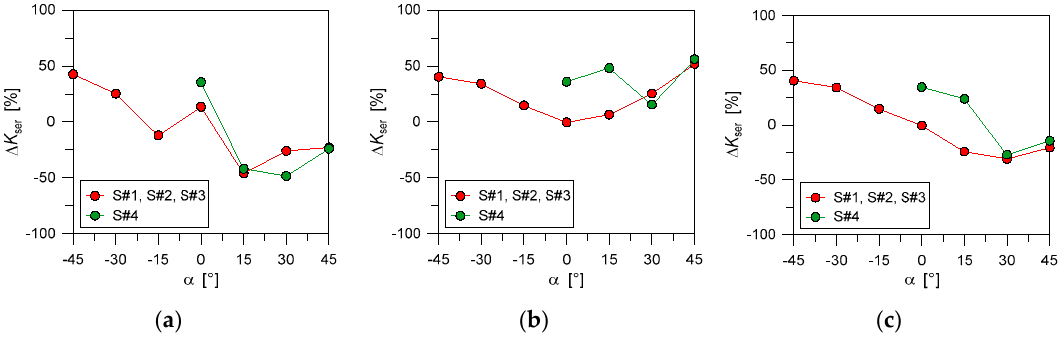
Figure 15. Percentage scatter of stiffness values for TTC joints with inclined STSs (Equation (5)), as obtained from the FE numerical analyses (ABAQUS/Explicit) and by literature [6]: ( a ) experimental data, ( b ) single stiffness analytical model, ( c ) double stiffness analytical model.